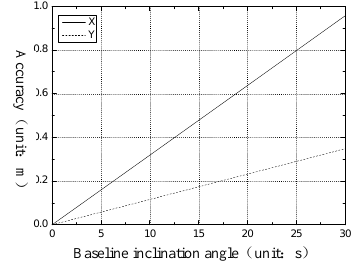
Figure 5 Baseline inclination angle’s error’s